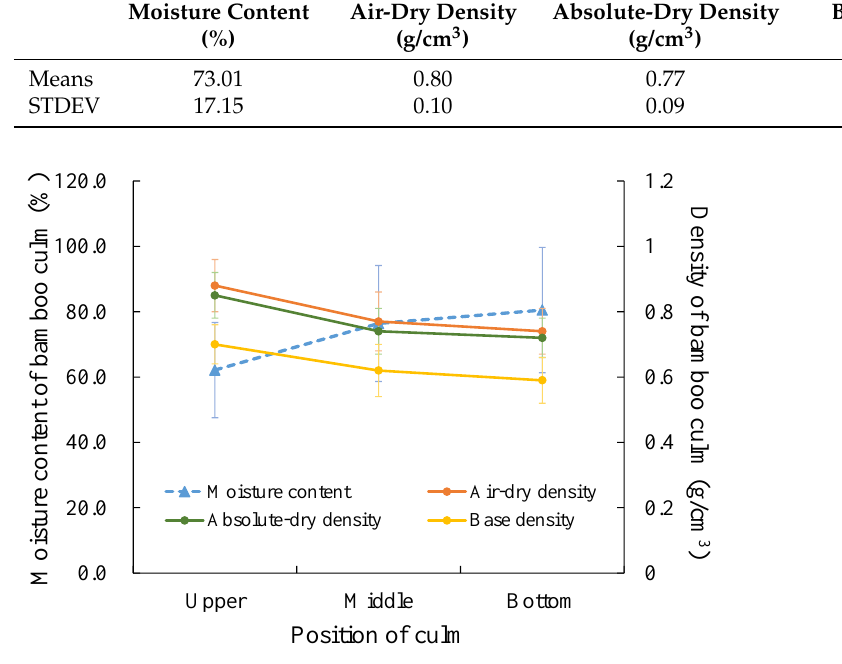
Figure 4. The moisture content and densities of the culm wall in different culm position.